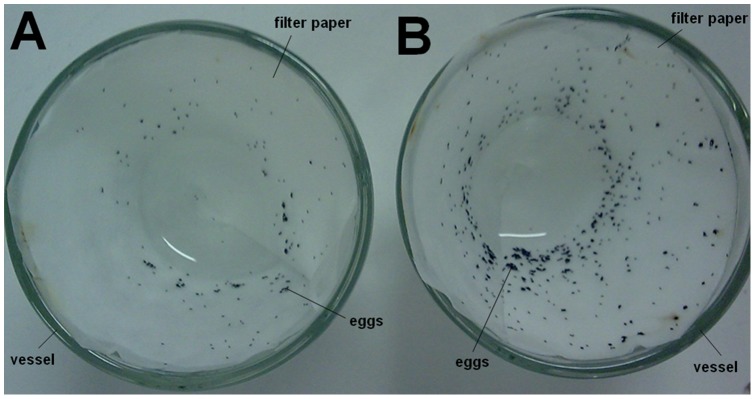
Top view of glass vessels used in oviposition assay.A filter paper cone was placed covering the inner of each vessel to provide a support for oviposition. Next, the vessels were filled with distilled water (A, control) or WSMoL at 0.1 mg/mL in distilled water (B).